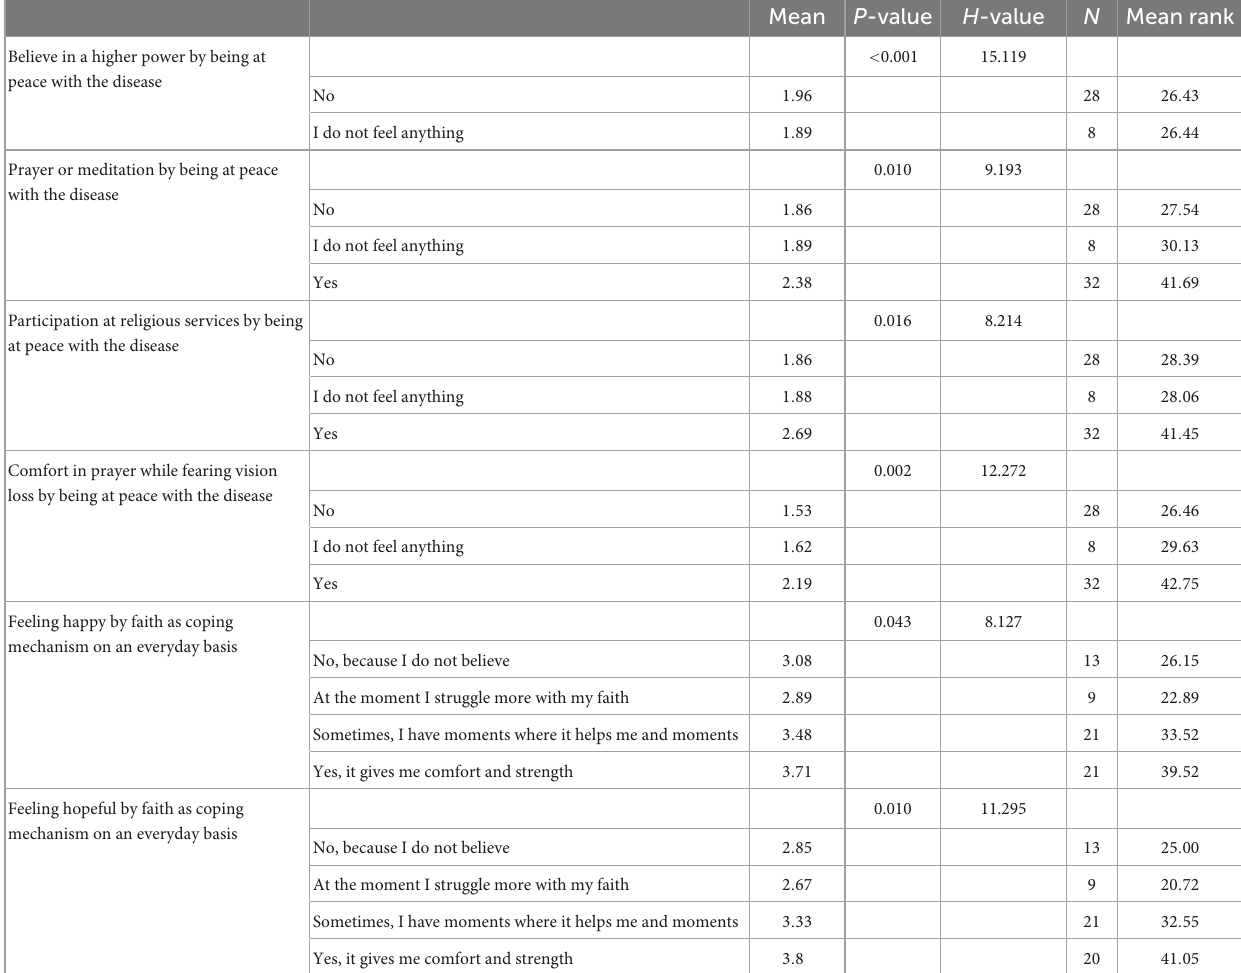
TABLE 6 The results of the Kruskal–Wallis test for the international group.